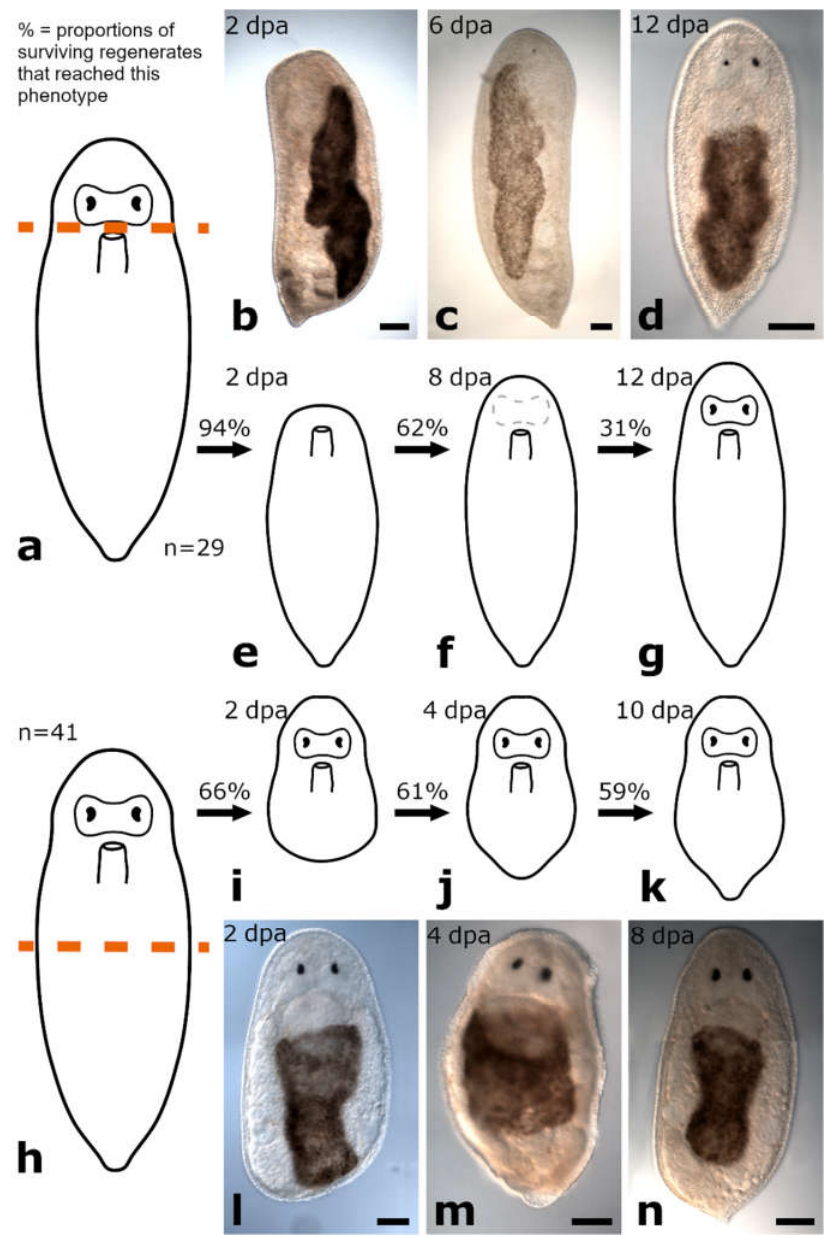
Figure 8. Regeneration in Plagiostomum girardi . Anterior regeneration after amputation between brain and pharynx ( a – g ). The wound was fully healed ( b , e ). The original head shape was restored ( c , f ). Eye regeneration ( d , g ). Posterior regeneration after amputation posterior to the pharynx ( h – n ). Complete wound healing ( i , l ). A small blastema-like structure was built at the incision site ( j , m ) and lead to the regeneration of a pointy tail was regenerated ( k , n ). Scale bars are 100 µm.